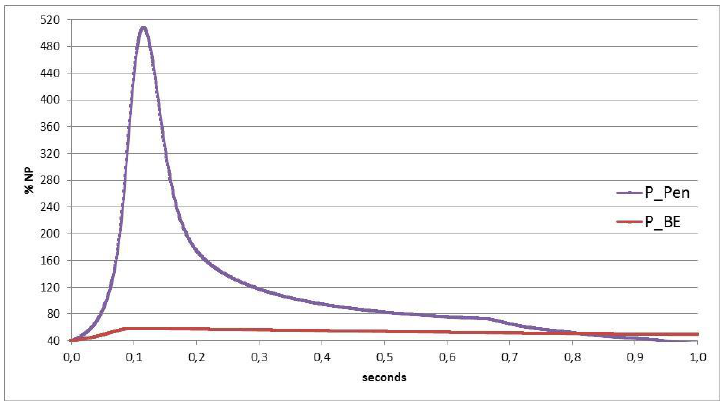
Figure 2: Power transient in case of REA with (P_Pen) and without penalties (P_BE) The penaltie s' effects are clearly visible. The ‘penalized' power peak is a magnitude order bigger than the Best-Estimate